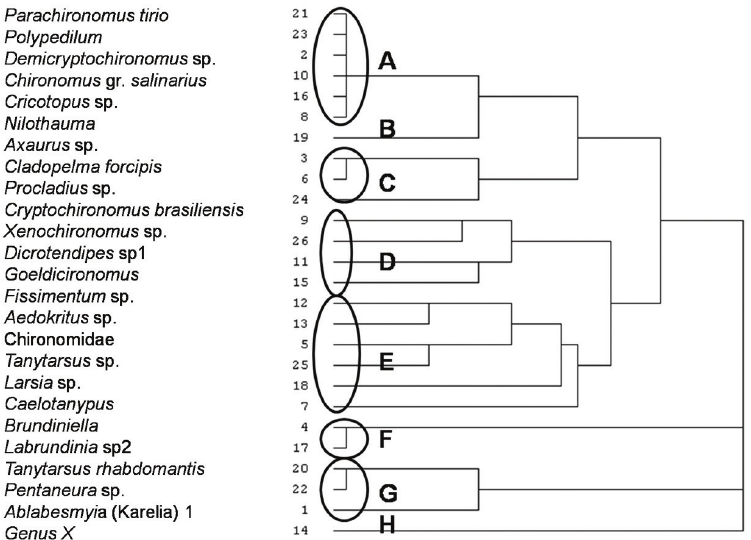
Figure 6. Dendrogram of Chironomidae genera with respect to different depths (m) in Lake Figueira by Cosine’s algorithm, (A) genera in depths of at least 8 m, (B) genera between 8 m and 11 m, (C) genera in depths from 2.5 m to 8 m, (D) and (E) genra which have no preference for by any depth in particular, (F) and (G) genera in depths from 1 m to 9 m respectively. The group H is composed of Genus X only, which is found in depths of less than 1